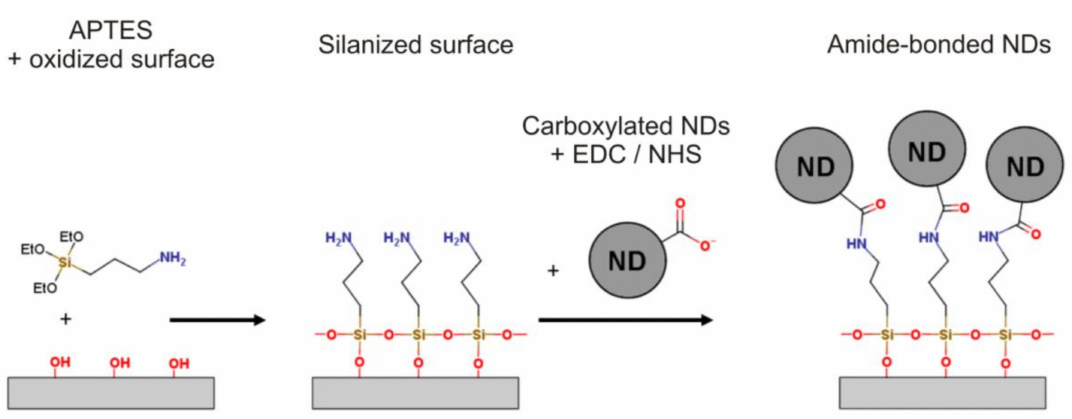
Figure 1. Covalent immobilization using (3-Aminopropyl)triethoxysilane and 1-Ethyl-3-(3-dimethylaminopropyl)carbodiimide and N-Hydroxysuccinimide (EDC/NHS) activation of carboxylated NDs. Modified from [40].